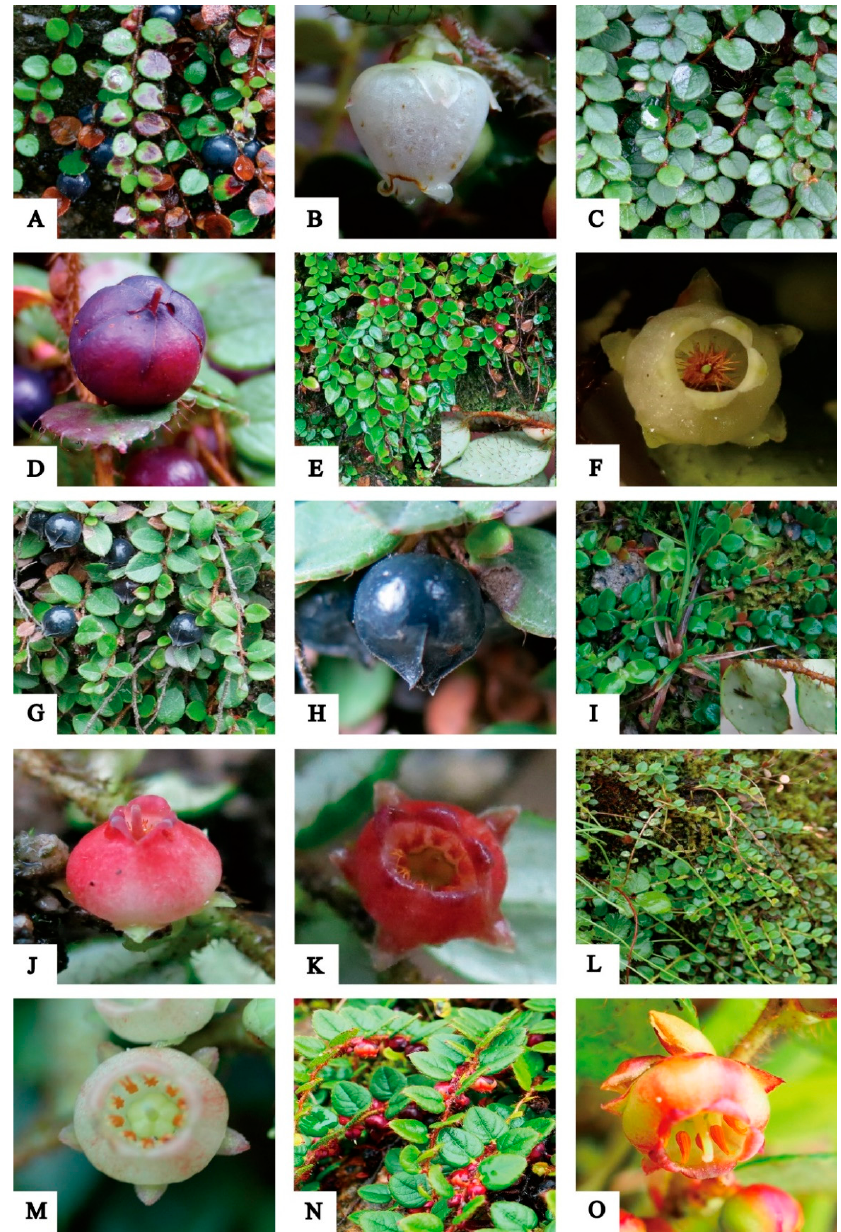
Figure 1. Phenotypic diversity of Gaultheria nummularioides . For population code and voucher details see Table S1. Text in parentheses refers to the population voucher code. ( A , B ), population HLG (L. Lu et al. LL-2011-27): ( A ), prostrate habit and bluish black fruits, ( B ), white narrowly urceolate corolla; ( C , D ), Population TQ (L. Lu et al. LL-2011-38): ( C ), subrhombic to orbicular leaf blades, ( D ), purple immature fruits with exposed style, and branches and abaxial leaves with indumentum; ( E , F ), Population GS-3 (L. Lu et al. LL-2013-29): ( E ), ovate to subrhombic leaf blades, densely hirsute on abaxial surface (bottom right), ( F ), white narrowly urceolate corolla; ( G , H ), Population GS-2 (L. Lu et al. LL-2013-24): ( G ), prostrate habit and bluish black fruits, ( H ), bluish black fruits with long calyx lobes and occluded style; ( I – K ), Population LSD (L. Lu et al. LL-2014-32): ( I ), prostrate habit with small ovate leaves, sparsely hirsute on abaxial surface (bottom right), ( J ), deep pink broadly urceolate corolla, ( K ), whitish pink broadly urceolate corolla; ( L , M ), Population DXL (L. Lu et al. LL-07096): ( L ), prostrate habit with small ovate leaves, ( M ), light pink broadly urceolate corolla; ( N , O ), Population NDL (L. Lu et al., LL-2018-15): ( N ), branches, and abaxial surface and margins of leaves with indumentum, ( O ), whitish red broadly urceolate